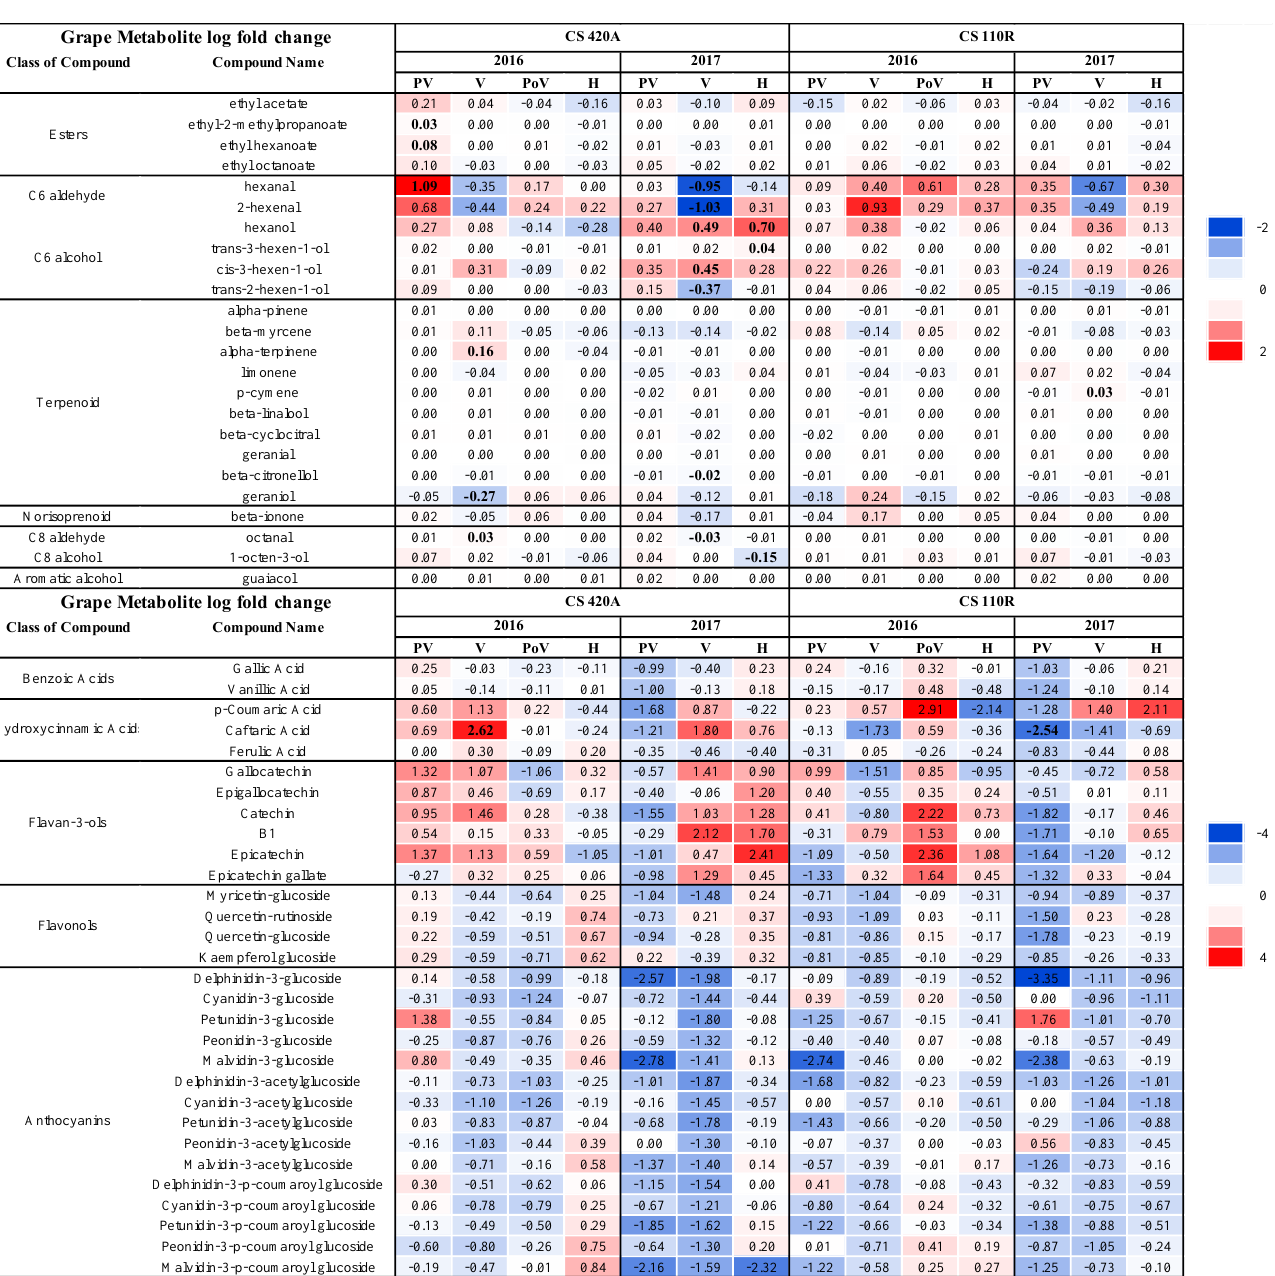
Figure 2. Log fold changes of secondary metabolite concentrations through ripening in Cabernet Sauvignon grapes grafted onto 110R and 420A rootstocks in 2016 and 2017. Negative values (blue) indicate a decrease in concentration and positive values (red) indicate an increase in concentration in RB(+) grapes compared to RB(−) grapes. Color gradient indicates the size of log fold change. Bolded values indicate a significant difference ( p < 0.05, FDR correction). CS = Cabernet Sauvignon, PV = pre-veraison, V = veraison, PoV = post-veraison, and H = harvest. The interaction between disease statues and season indicated that seasonal differ- ences mainly affected 420A rootstock. At veraison, α -terpinene, octanal, and trans-2- hexen-1-ol were significantly affected by season, and hexanol at harvest. Only p -cymene